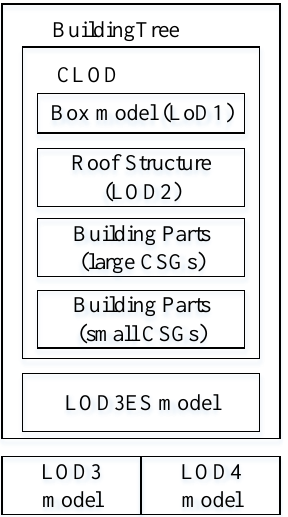
Figure 2. BuildingTree structure.